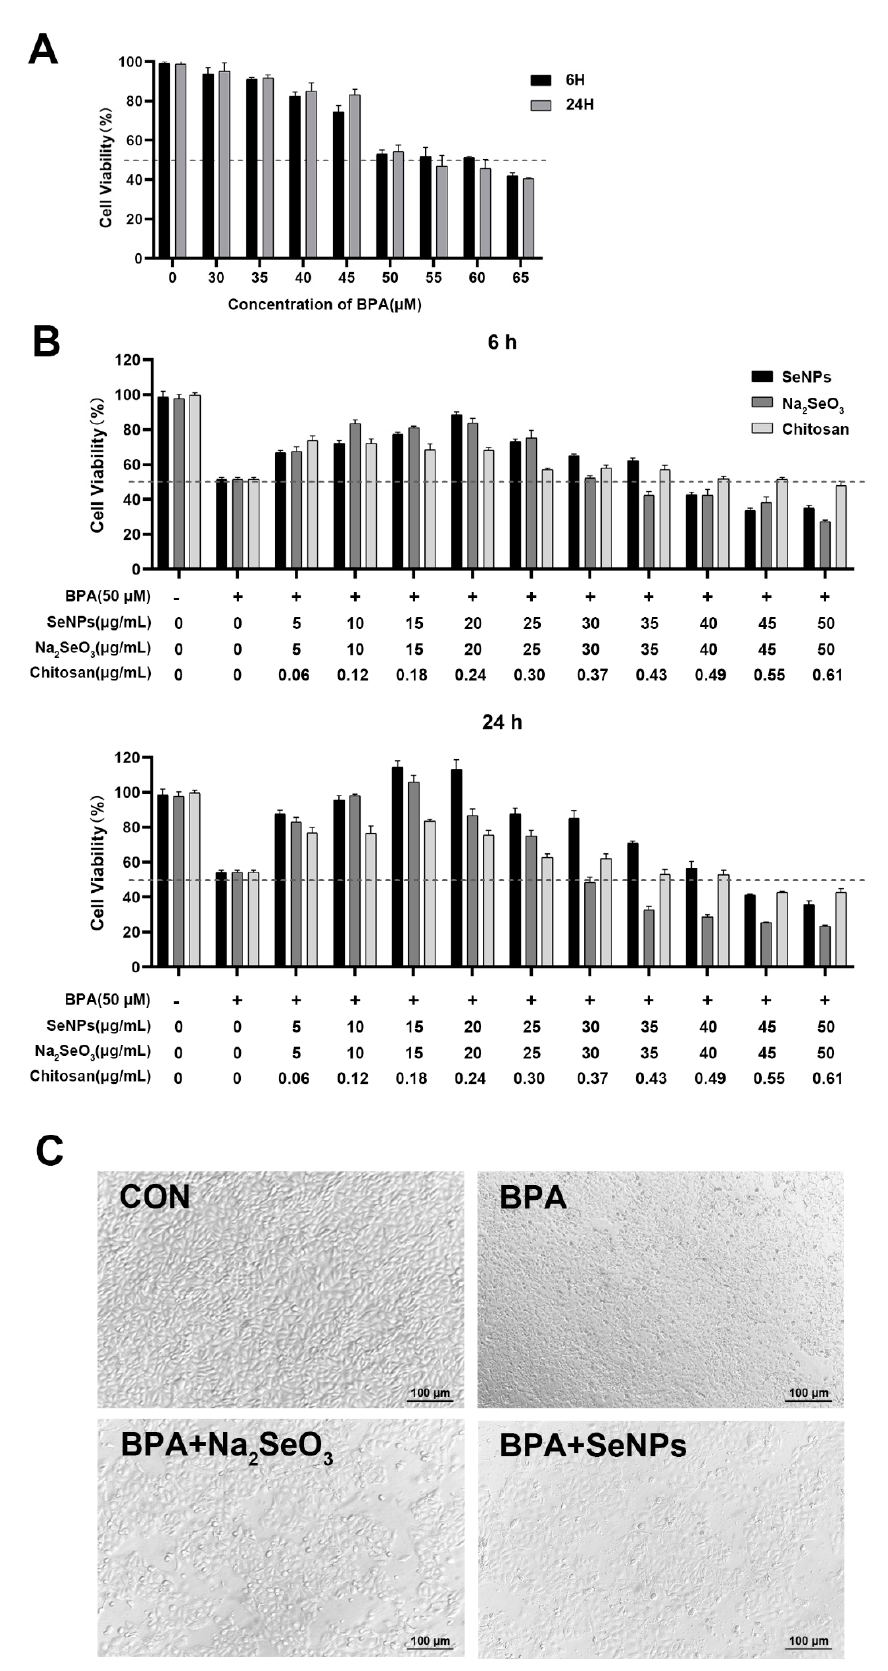
Figure 2. Effects of Na 2 SeO 3 and SeNPs on viability and morphology of IPEC-J2 after BPA exposure. The dashed line represented the standard line of 50% cell viability. The optimal concentration of